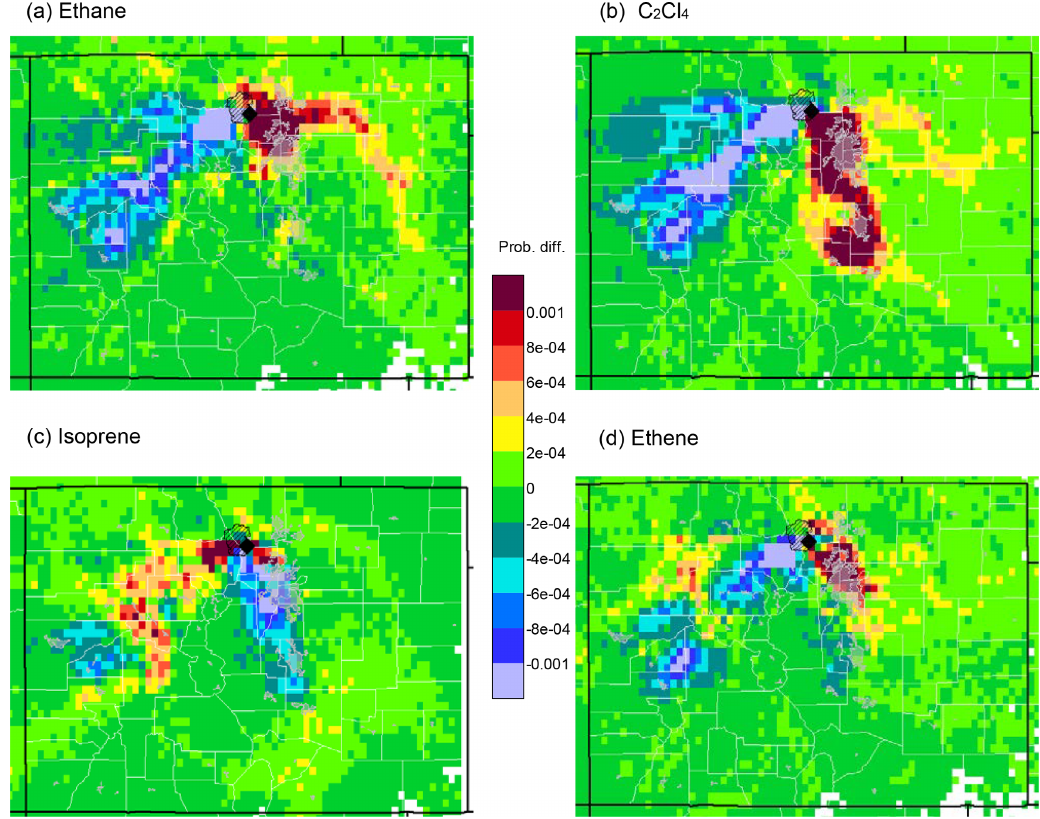
Figure 5. Differences between upwind transport during hours of 90th percentile or higher mixing ratios and average conditions during the study (HRT − ORT) for (a) ethane, (b) C 2 Cl 4 , (c) isoprene, and (d) ethene. Yellow to red colors indicate areas that were more likely than average to be upwind during the 2 days prior to a high-concentration measurement at ROMO-LP (black diamond). Blue to purple colors indicate areas that were less likely to be upwind, while areas in green had similar likelihoods of being upwind during average hours and during high-mixing-ratio hours. Light-grey overlay indicated urban